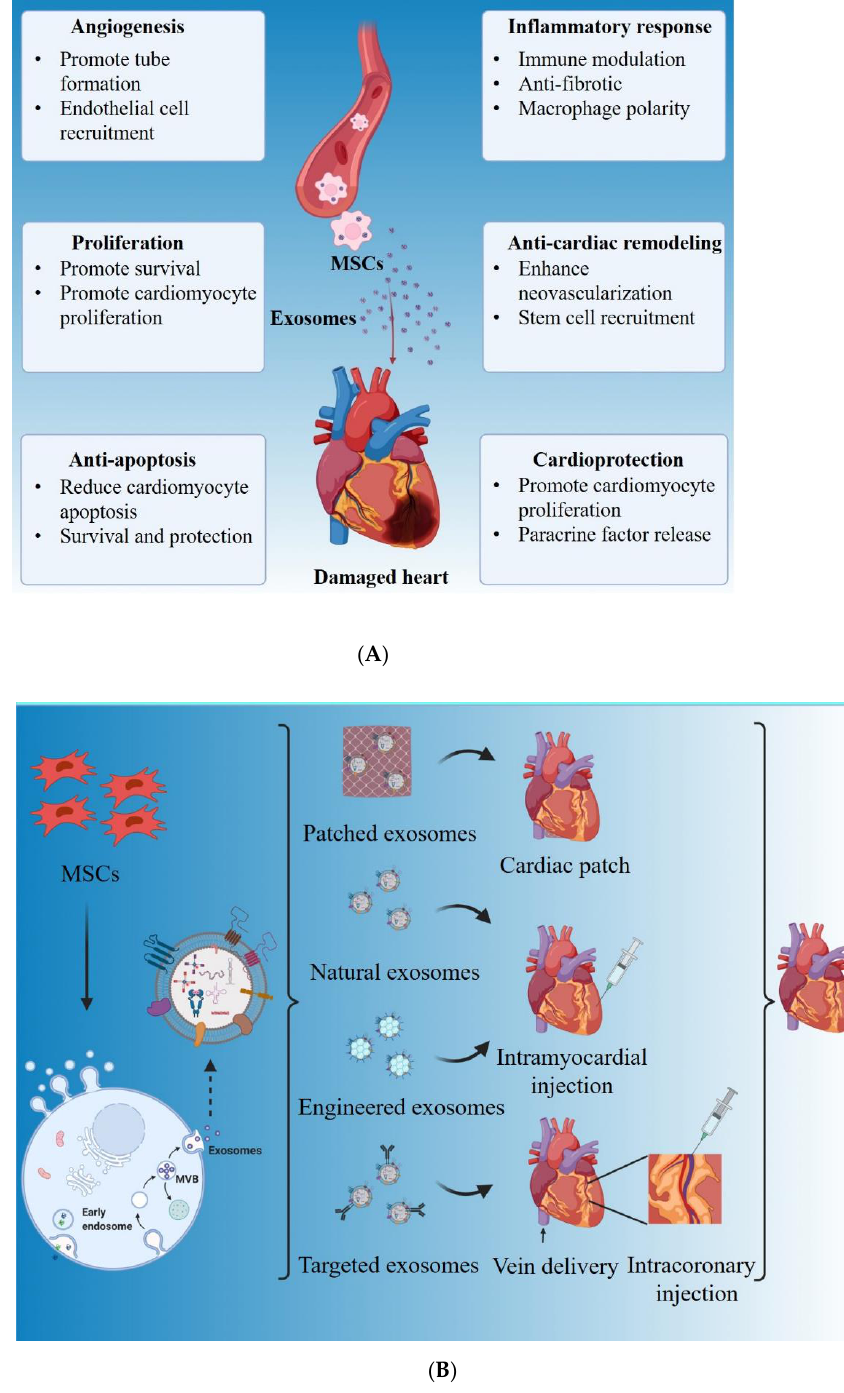
Figure 7. Stem cell-derived exosomes for cardiac repair therapies. ( A ) Exosomes isolated from different types of mesenchymal stem cells carry and deliver proteins, nucleic acids (DNA, miRNAs, mRNAs, and other RNAs) and metabolites to the damage heart tissue, consequently promoting cardioprotective effects. ( B ) Schematic representation of tissue engineering approaches in exosome-based cardiac repair therapies. MSCs or exosomes can be genetically modified with tRNA, miRNA or mRNA to express the desired gene using gene delivery methods or CRISPR/Cas9. MSC-derived exosomes can act as therapeutic vehicles to deliver biological molecules or drug molecules and further immersed in scaffolds and delivered as patch, injectable scaffold, or 3D tissue construct to increase the functions of exosomes. Similarly, exosomes can be chemically conjugated with targeted peptides to further enhance efficacy and retention when delivered intravenously.